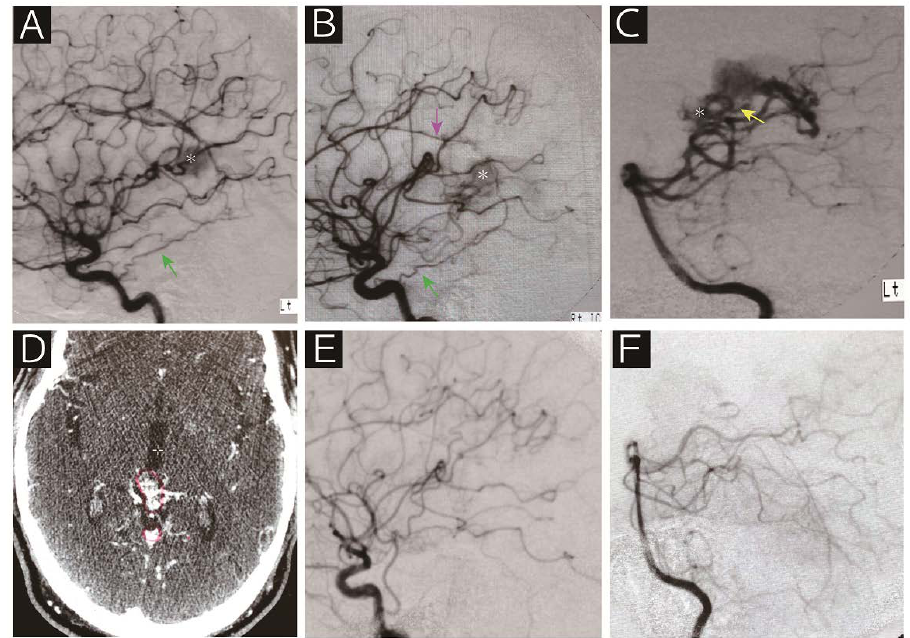
Figure 2. A 62-year-old man who presented with epilepsy was referred to us for radiosurgical treatment for an arteriovenous malformation. Digital subtraction angiography ( A , left internal carotid artery; B , right internal carotid artery; C , left vertebral artery) showed that the nidus (asterisk) was supplied by the bilateral tentorial artery (green arrow), right callosal artery (purple arrow), medial posterior choroidal artery (yellow arrow) and posterior cerebral artery perforators. Contrasted